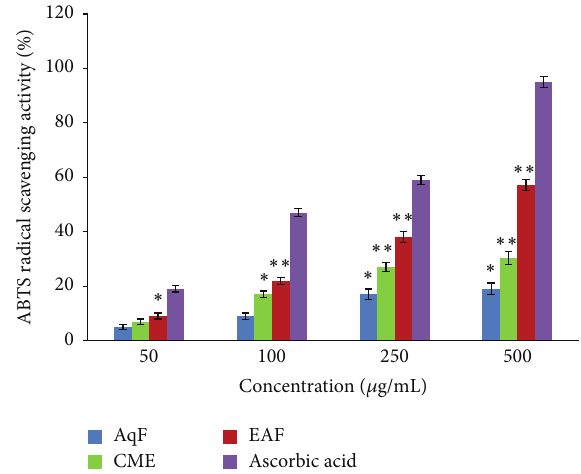
Figure 2: ABTS ∙+ radical-scavenging assay of the extracts and fractions. EDTA was used as the positive control. Each value is expressed as a mean ± SD ( 𝑛 = 3 ). ∗ 𝑃 < 0.05 and ∗∗ 𝑃 < 0.01 , compared to the standard with extract and fractions (one-way ANOVA followed by Dunnett’s